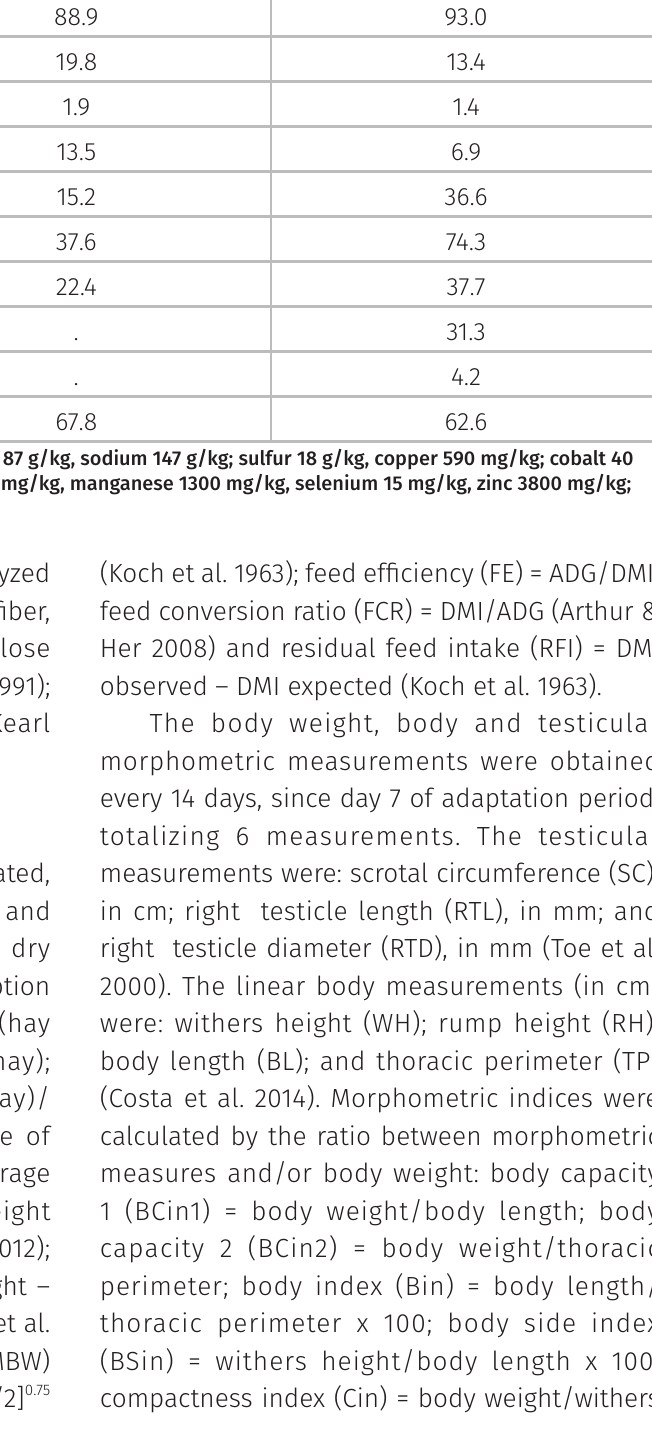
Table I. Chemical composition of the hay and concentrate in % of dry matter. Chemical composition